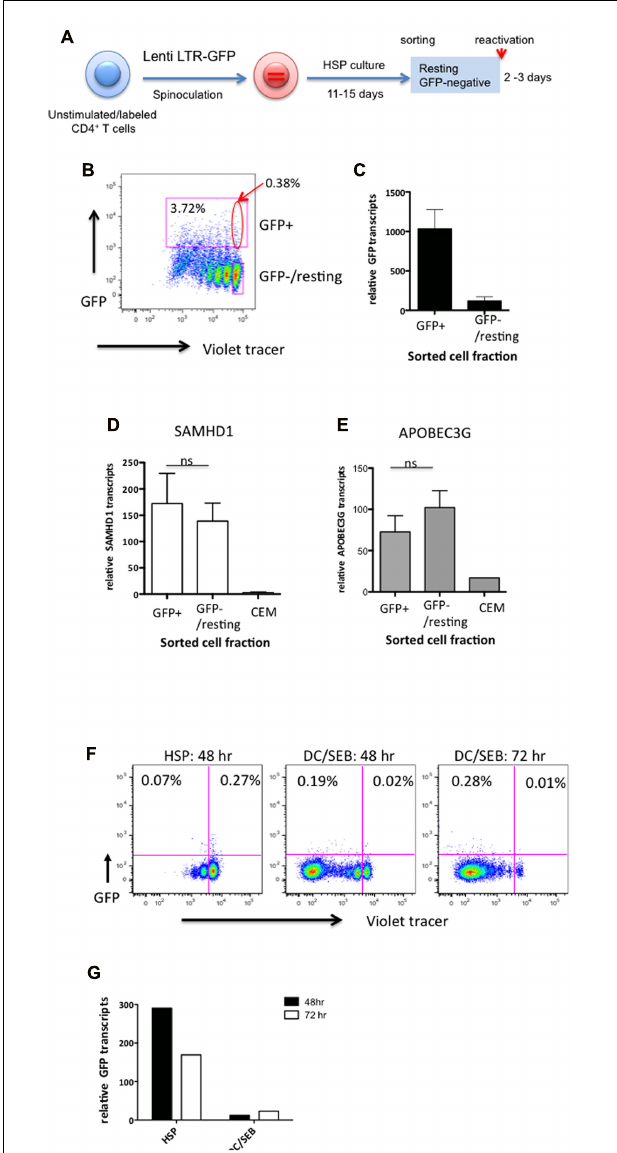
FIGURE 3 | The impairment of the HIV marker gene expression (GFP) in HSP-cultured resting CD4 + T cells is not linked to increased levels of SAMHD1 or APOBEC3G, and is not induced upon TCR engagement by antigen-pulsed dendritic cells. (A) Outline of experimental strategy. Violet tracer-labeled CD4 + T cells were infected with Lenti LTR-GFP and cultured under HSP conditions for 11–15 days. GFP-positive and resting GFP-negative cells were sorted by preparative flow cytometry as marked in the analytical dot plot (B) . Total RNA from both cell populations was isolated, reverse transcribed with random hexamers and subjected to quantitative PCR specific for GFP (C) , SAMHD1 (D) , and APOBEC3G (E) transcripts. RNA isolated from CEM cell lysates was used as control for SAMHD1 and APOBEC3G transcripts. Transcript levels were normalized to endogenous EF-1 α (C) or RNase P (D,E) mRNA levels. For panels (F,G) , resting GFP-negative cells were sorted by preparative flow cytometry and cultured in HSP conditions (HSP), or the presence of SEB-pulsed DCs (DC/SEB). Cell proliferation (Violet tracer) and GFP expression were analyzed by flow cytometry after 48 or 72 h (F) . GFP transcripts were analyzed by quantitative RT-PCR from isolated total RNA (G) . Transcripts levels were normalized to endogenous EF-1 α mRNA levels.